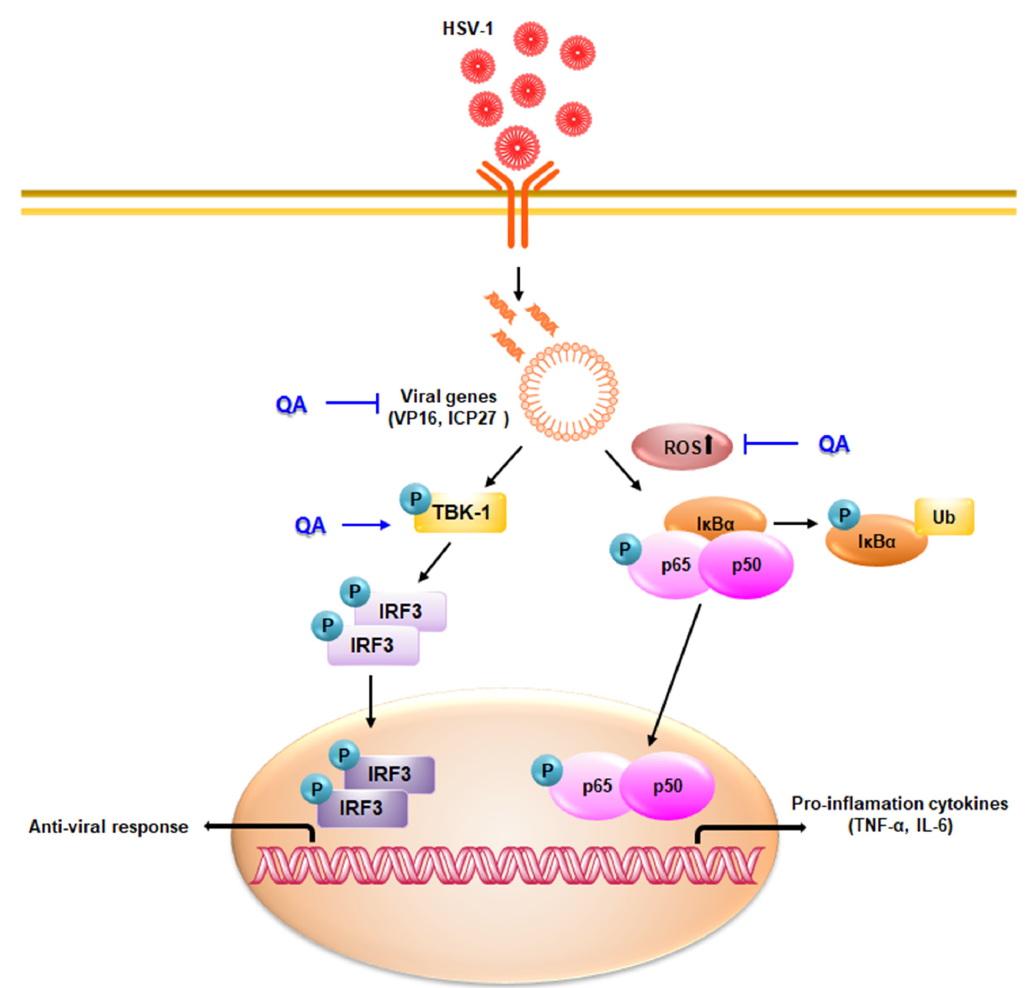
Figure 10. An antiviral mechanism of QA by HSV-1 infection in brain cells. QA attenuates viral infection by inhibiting ROS and NF-kB activity following HSV-1 infection. QA induces TBK-1/IRF3 activity, thus exhibiting antiviral effects.